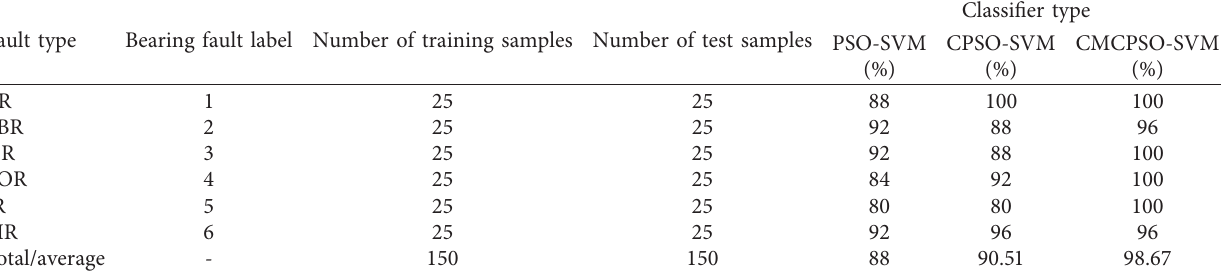
Table 4: Classification accuracy of the three diagnosis models. Fault type Bearing fault label Number of training samples Number of test samples